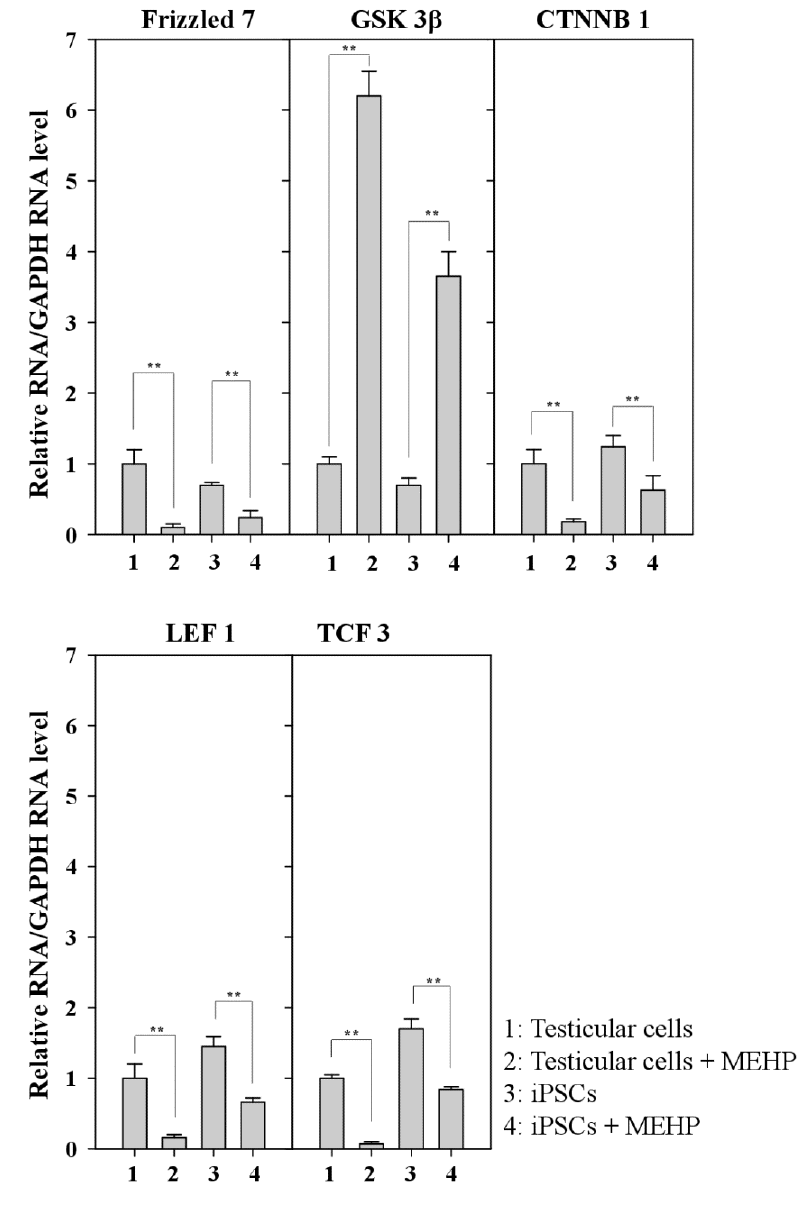
Figure 6. Relative expression of genes related to the WNT/ β -catenin canonical pathway. Relative expression of a series of Frizzled, GSK3 β , CTNNB, LEF1, and TCF3 in bovine testicular cells and iPSCs. (Lane 1, control DMSO (0.001%) in testicular cells; lane 2, 10 − 4 M MEHP in testicular cells; lane 3, control DMSO (0.001%) in iPSCs; lane 4, 10 − 4 M MEHP in iPSCs. The values expressed as means ± SEM, n ≥ 3; ** p <